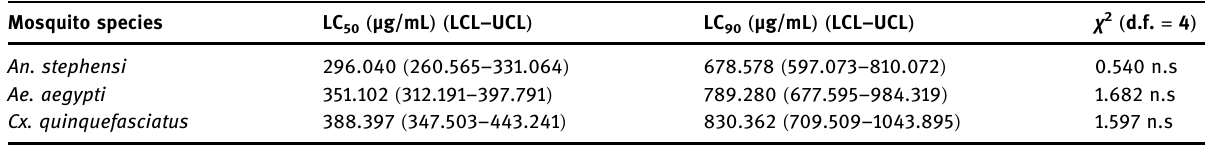
Table 3: Adulticidal toxicity of chitosan against An. stephensi, Ae. aegypti , and Cx. quinquefasciatus . Mosquito species